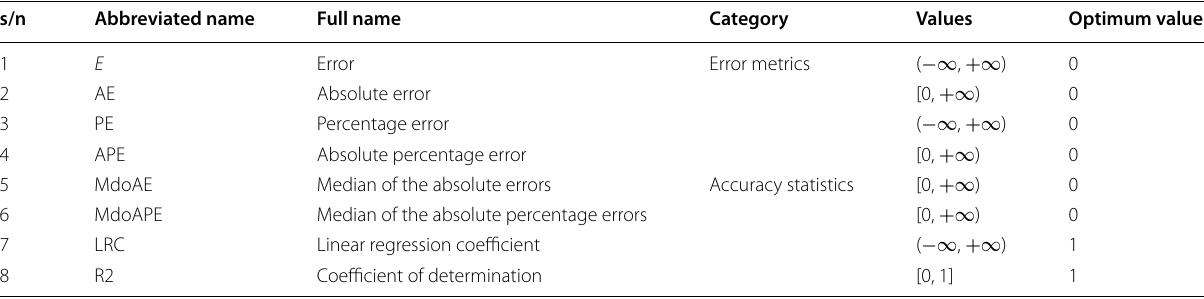
Table 8 Experiments of this study